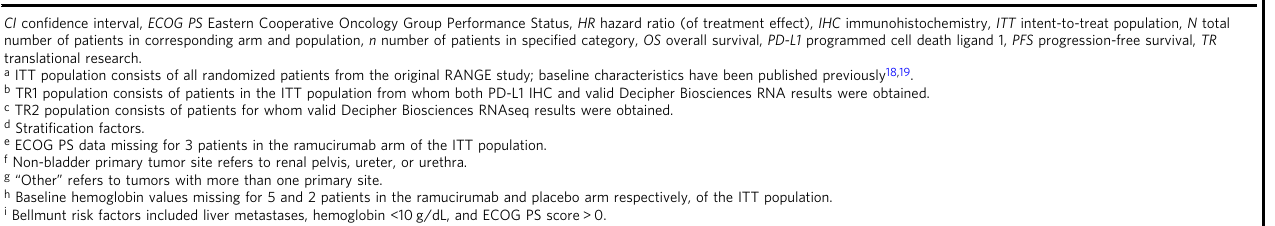
Urothelial carcinoma molecular subtype, PD-L1 status, and overall survival . We analyzed the mRNA dataset using three different gene expression-based UC molecular classi fi ers 11,21 (Supplementary Table 3). There was considerable overlap between ConsensusMIBC Basal/Squamous and the Basal and Decipher GSCv1 into an even split between Basal/Squamous and Stroma-rich subtypes. Analysis of the association between mole- cular subtype and PD-L1 CPS revealed that Basal tumor types of classi fi cation schemes were more likely to be CPS ≥ 10: 52.2% of Basal and 82.1% of Claudin Low subtypes using the Decipher the ConsensusMIBC classi fi er 11 (Fig. 3a), and 76.9% of the Basal Squamous subtype using TCGA were CPS ≥ 10. In contrast, Luminal tumor types of UC classi fi cation schemes were more